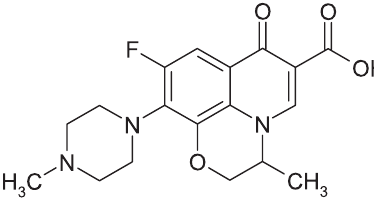
FIGURE 1 - Chemical structure of